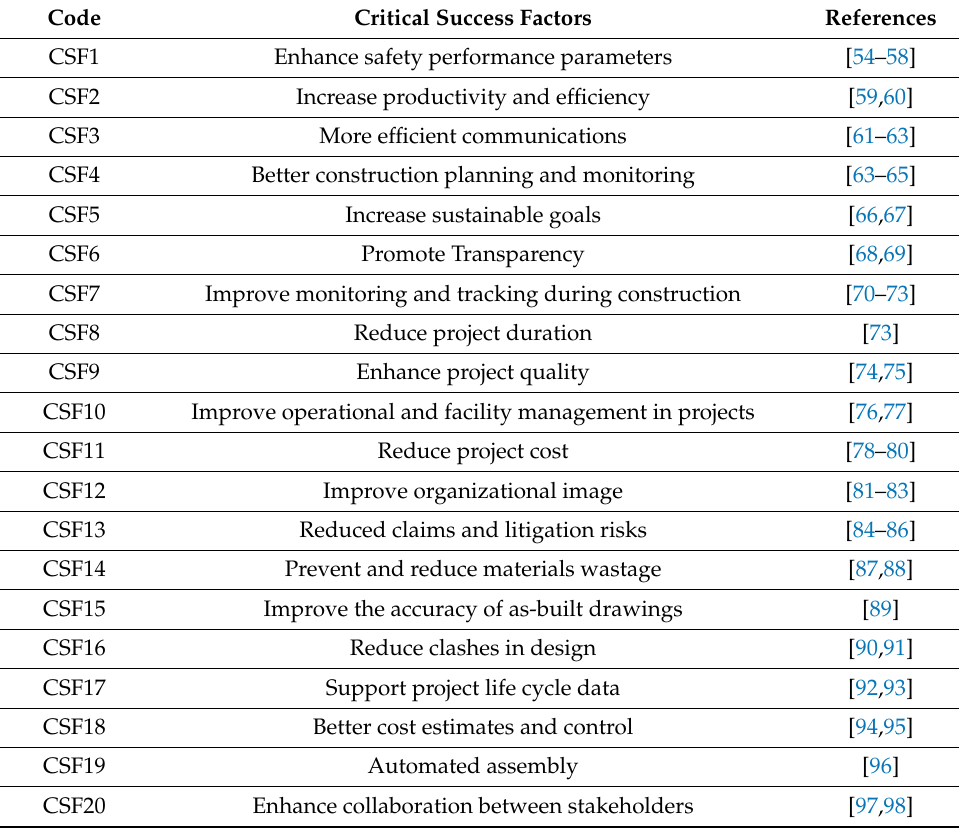
Table 1. Critical success factors of BIM